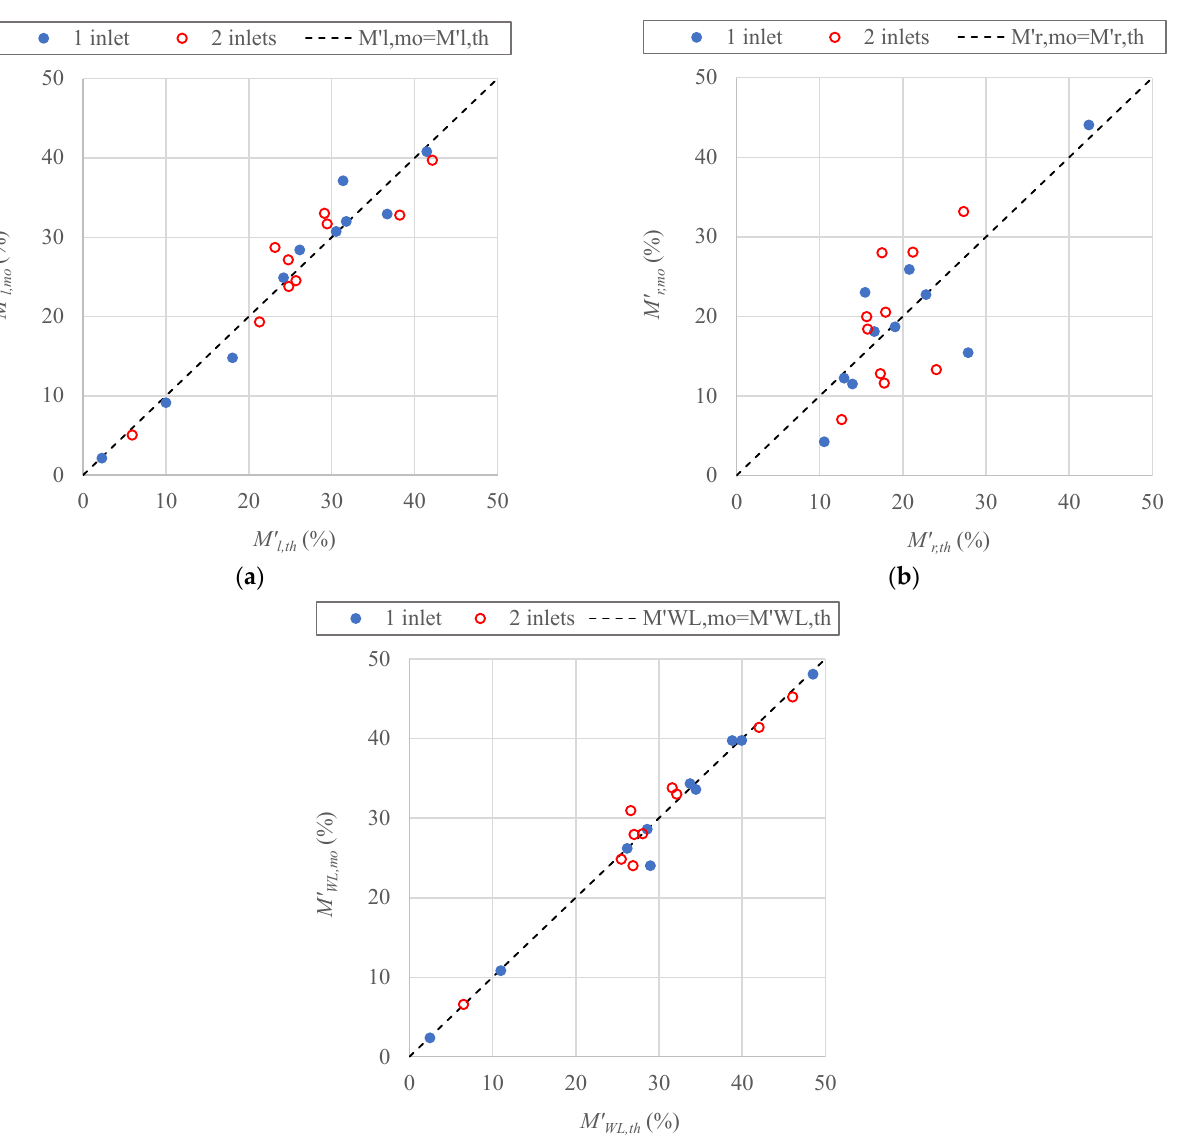
vs. M (cid:48) , ( b ) M (cid:48) r , mo vs. M (cid:48) , and ( c ) M (cid:48) vs. WL , mo l , mo l , th r , th